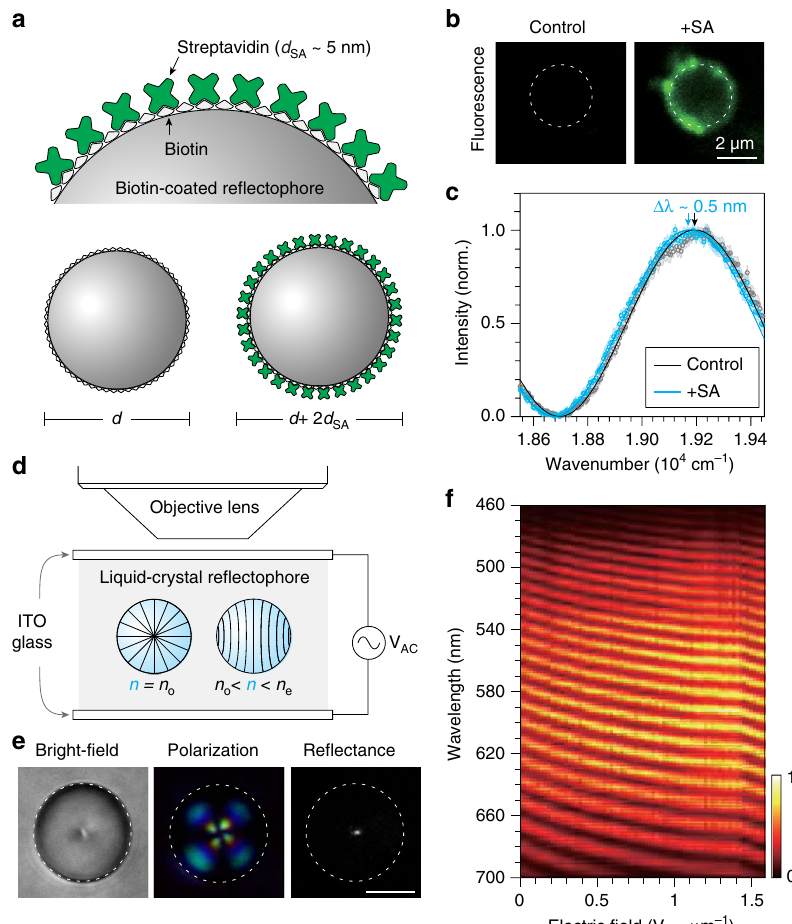
Fig. 6 Microenvironmental sensing. a Schematic illustration for the binding of streptavidin on a biotin-functionalized re fl ectophore. Upon binding, diameter increases by ~10 nm. b Fluorescence images before and after loading fl uorescent streptavidin. Note that fl uorescence was localized speci fi cally at the surface of the re fl ectophore. c SpeRe measurements on control and streptavidin-bound re fl ectophores. The arrows indicate the spectral peaks. Data are represented as mean (open circle) and the standard deviation (shaded region) was acquired from 30 repeated SpeRe measurements. The solid lines are the best- fi t simulated spectra ( R 2 in mean ± standard deviation: 0.98 ± 0.005 for “ control ” , 0.98 ± 0.005 for “ + SA ” ). d Experimental setup for sensing electric fi eld with a liquid-crystal re fl ectophore. Nematic liquid-crystal droplet is immersed in PDMS and sandwiched between conductive ITO glasses coupled to a function generator. e Liquid-crystal re fl ectophore imaged by bright- fi eld, polarization, and re fl ectance microscopy. Scale bar, 4 μ m. f Spectral re fl ectance of liquid-crystal re fl ectophore in response to applied electric fi eld. Color bar represents normalized re fl